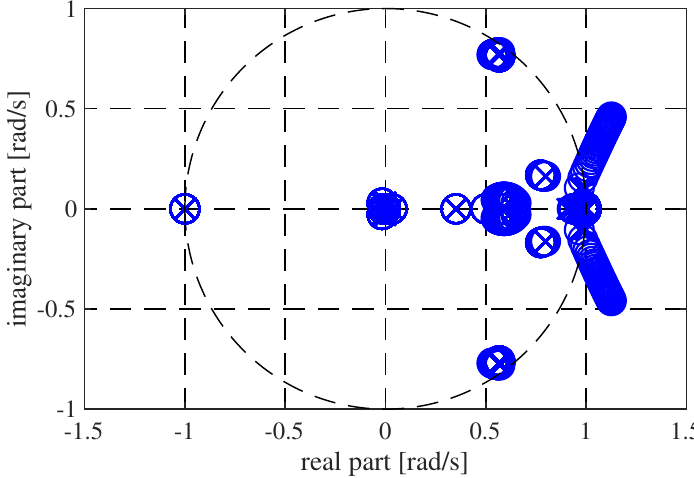
Figure 9. Zero-pole map. Poles (crosses); zeros